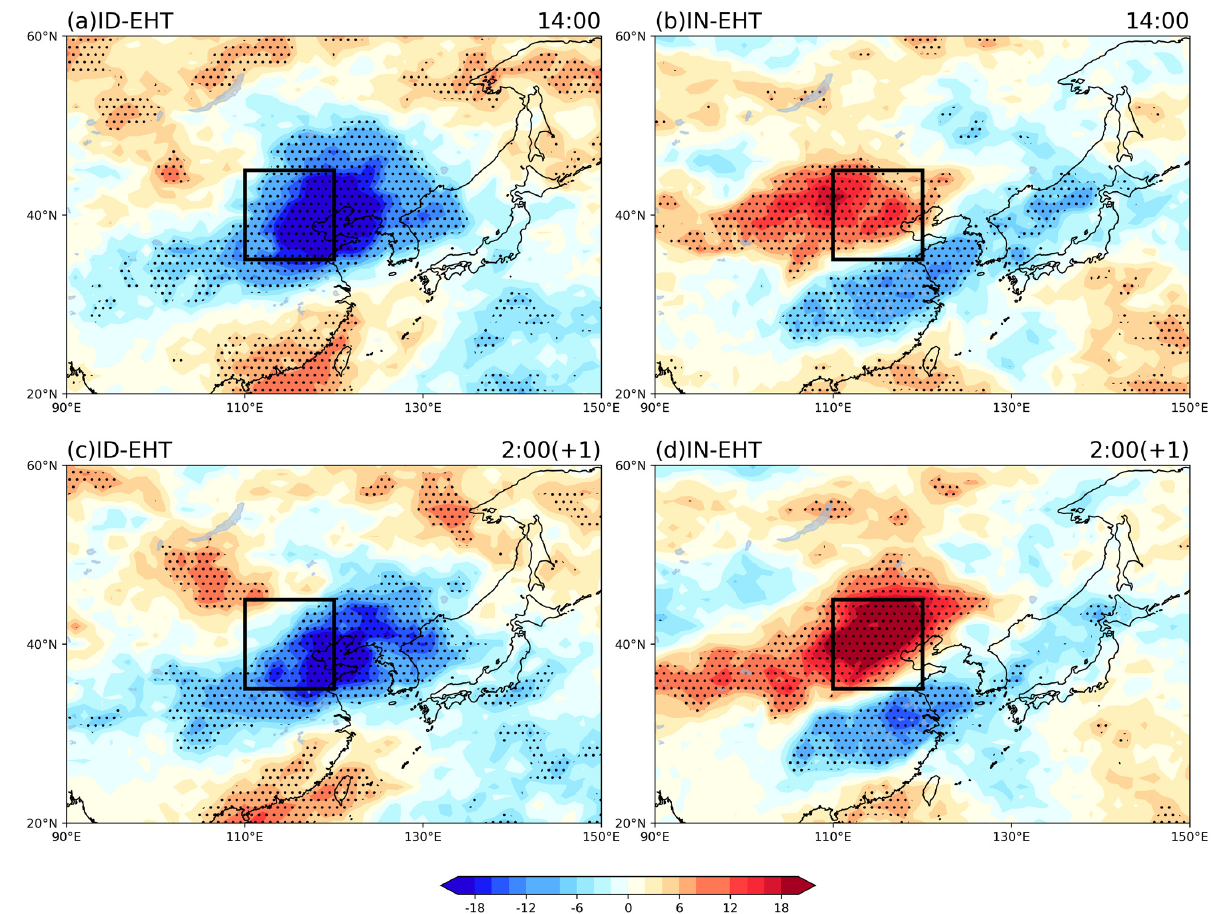
Figure 3. Composite anomalies of total cloud cover (shading; units: %) at 14:00 ( a ) and at 2:00 of the next day ( c ) for ID-EHT; ( b , d ) are same as ( a , c ) but for IN-EHT. Black dots indicate the anomalies significant at the 95% confidence level.